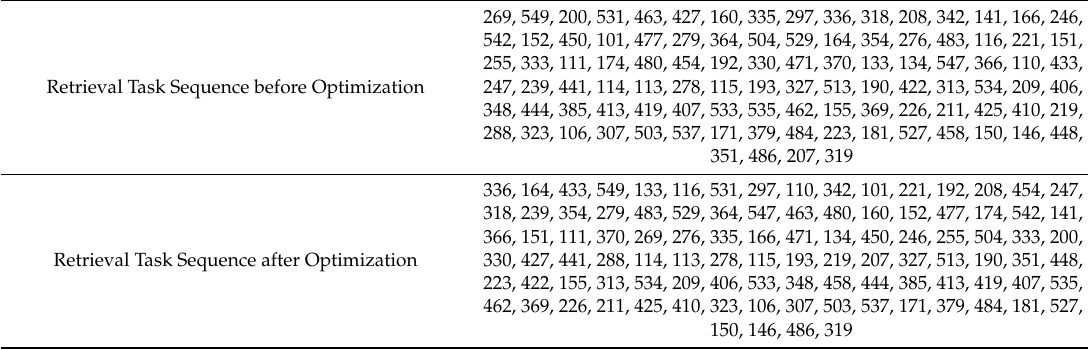
Table A3. The list of retrieval tasks before and after optimization when Task =